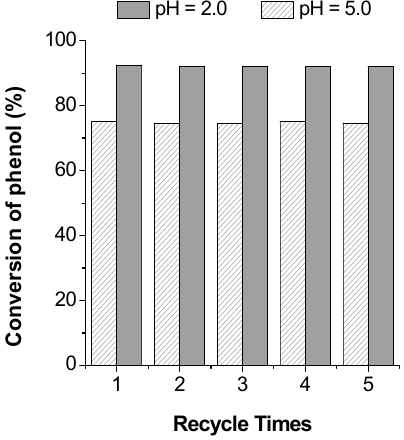
Figure 15. Conversion of phenol by CWPO using gold supported on hydroxyapatite as catalyst in consecutive five cycles of reutilization at pH = 2.0 and 5.0 ([phenol] = 100 mg/L, T = 70 °C, [catalyst] = 0.1 g/L and V H2O2 with 30 wt.% = 1 mL). Adapted from Han et al. [70].